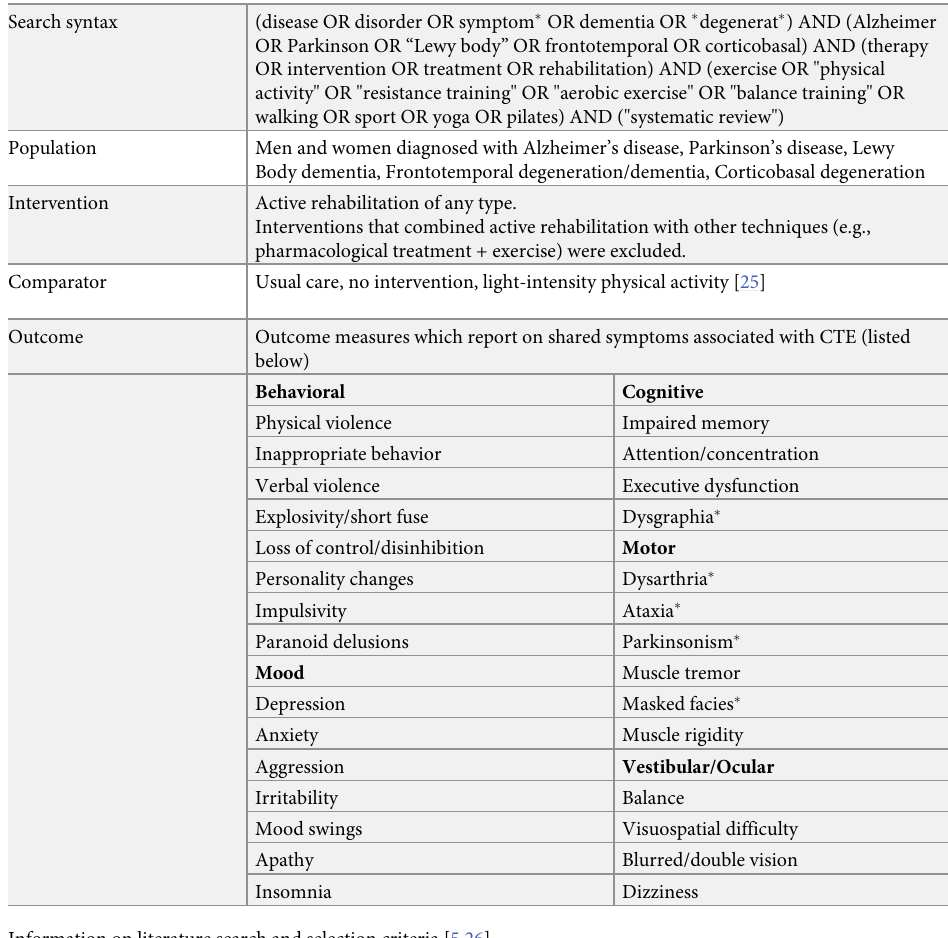
Table 1. Search and PICO. Search